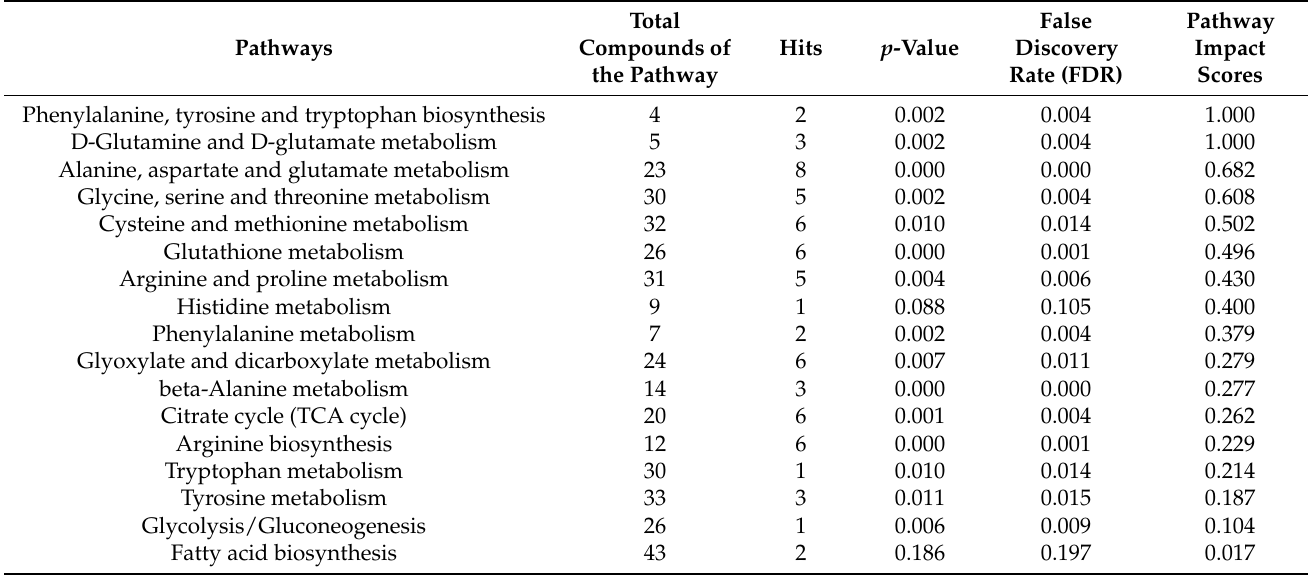
Table 2. List of pathways in abalone muscle that were affected by transport. Hits represent the total compounds of each pathway found in the samples.